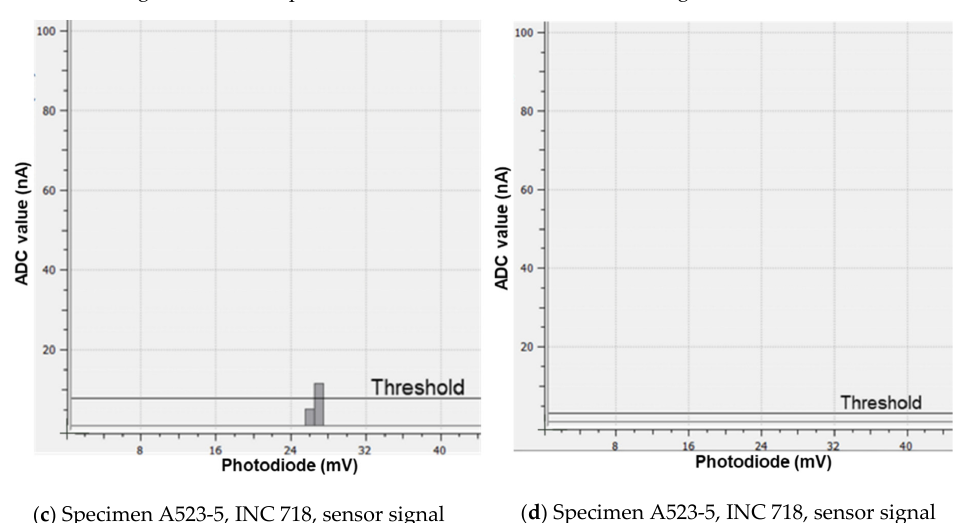
( b ) Specimen A523-5, INC 718, sensor signal strength at ~600 °C.